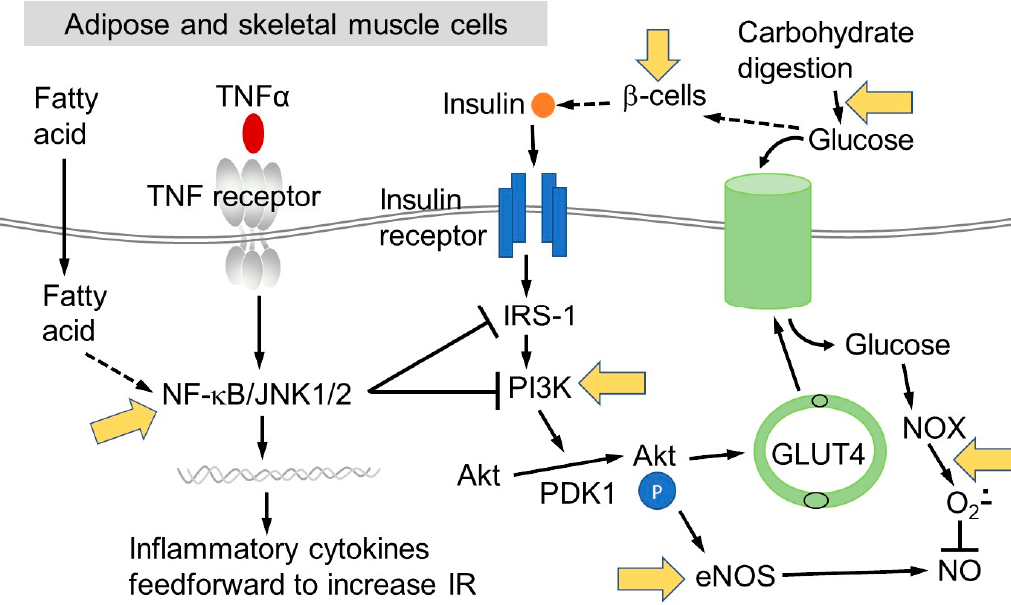
Figure 1. Simplified mechanism of glucose uptake by adipose or muscle tissue. Data combined